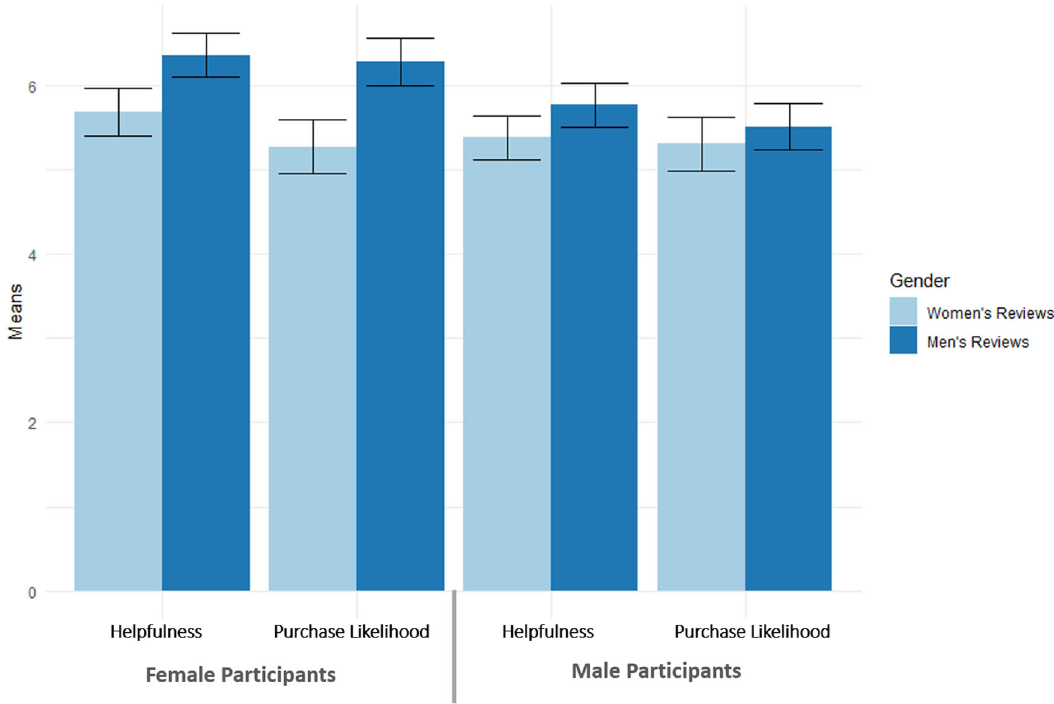
Fig. 3 Helpfulness and likelihood to purchase for reviews written by women vs. men, split by participant groups in study 1. Error bars represent